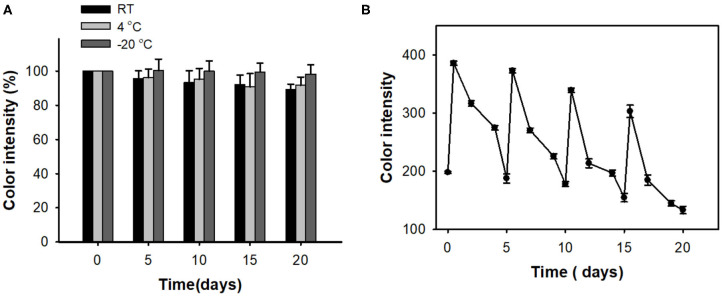
(A) Long-term storage stability and (B) reusability of paper strips for cholesterol detection.